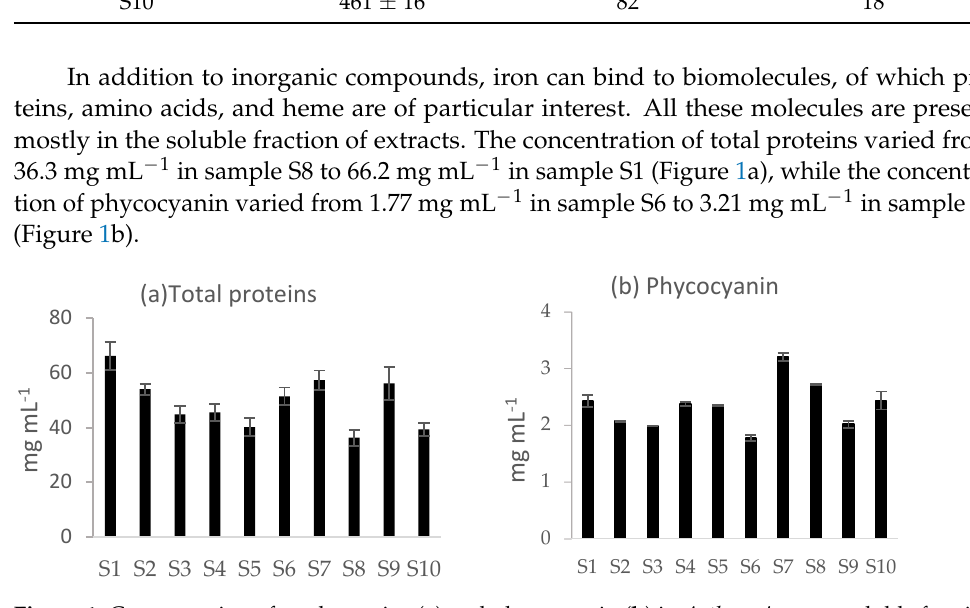
Figure 1. Concentration of total proteins ( a ) and phycocyanin ( b ) in Arthrospira spp. soluble fraction of commercial samples. Data are expressed in mg mL − 1 and are reported as mean ± SD (n = 3).